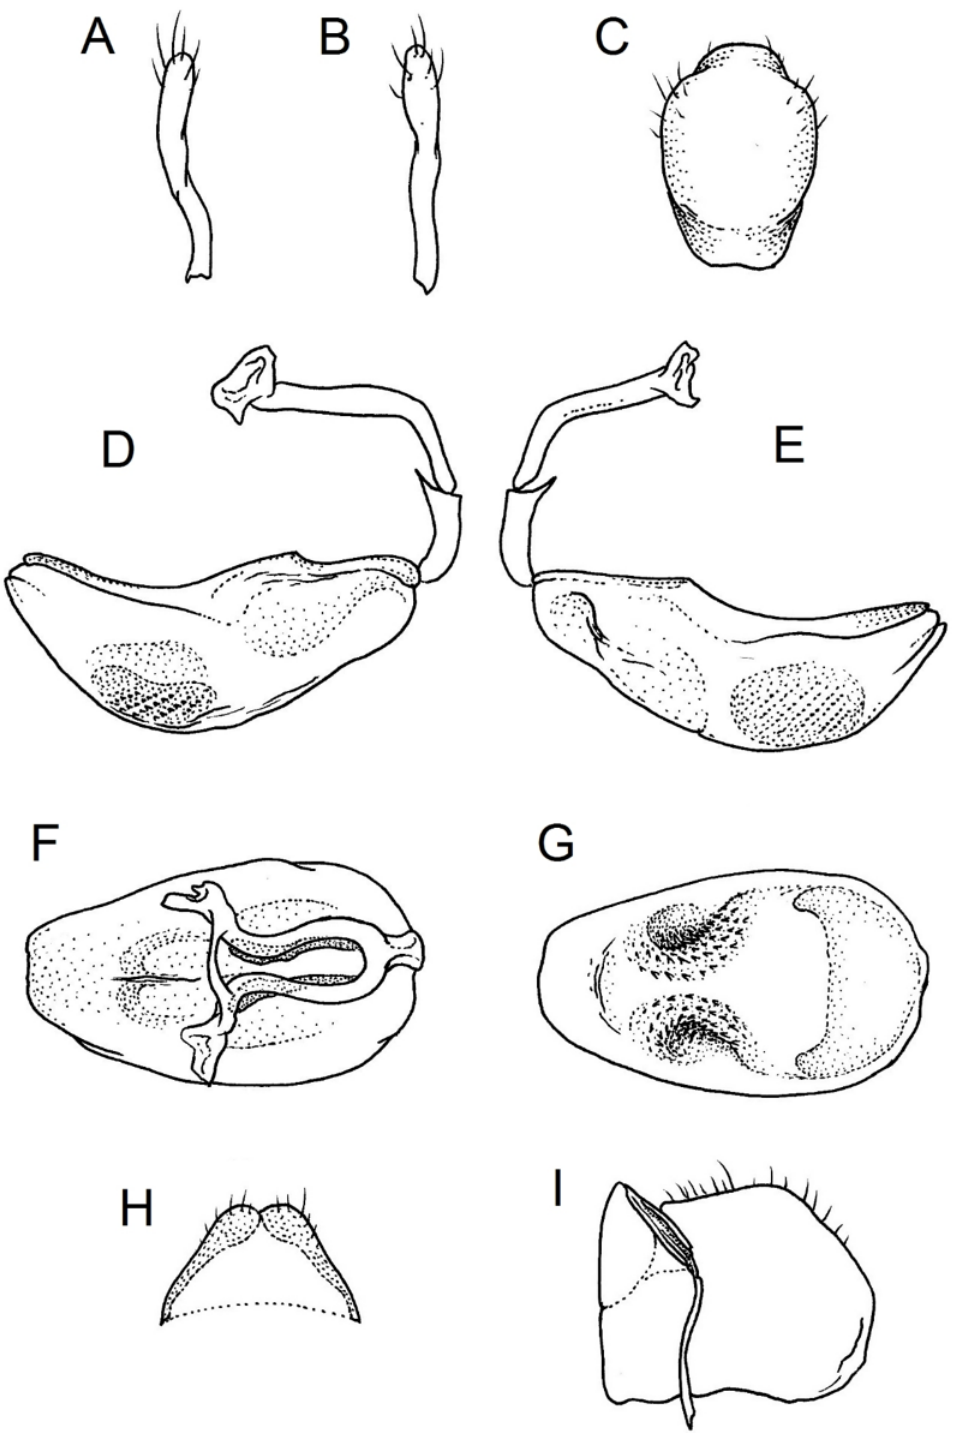
Figure 47. Phonoctonus luridus Miller, 1950: ( A ) left paramere; ( B ) right paramere; ( C ) pygophore, ventral view; ( D ) aedeagus, right lateral view; ( E ) aedeagus, left lateral view; ( F ) aedeagus, dorsal view; ( G ) aedeagus, ventral view; ( H ) styloids, outer view; and ( I ) gonocoxite of abdominal segment VIII. Redescription Colour : Body generally pale — orange and red with black patterns (Figure 30A).